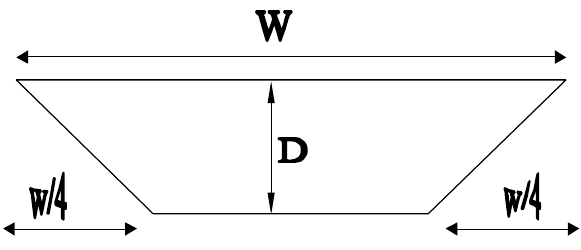
Fig. 3. Geometrical characteritics of a typical cross section of the Fig. 3 Geometrical characteritics of a typical cross section of the channel. channel. signal and a radiated one, while a free radiation condition was adopted on the east open sea boundary. The flow field is discretised horizontally by a 70 × 67 grid, with mesh size Dx =2.5 km. The time step is Dt =10 s, on the grounds of the √ 2 gh , where h is well-known Courant Criterion ( Dt<Dx/ the maximum water depth). A classical explicit difference scheme on a staggered grid is used for the solution of the mass and momentum conservation